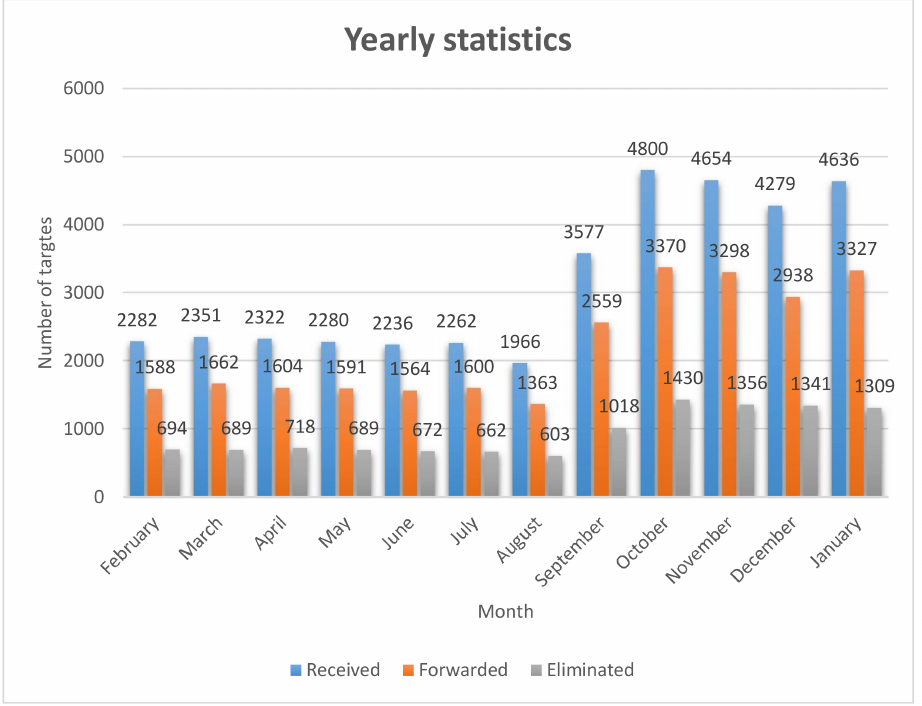
Figure 12. Yearly